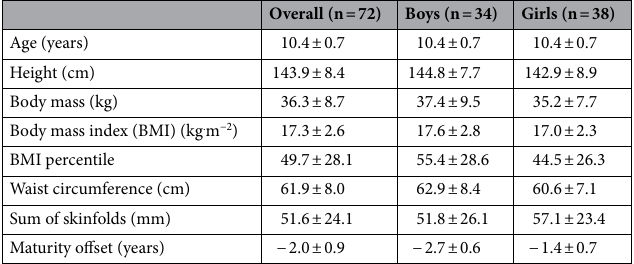
Table 1. Participant characteristics.